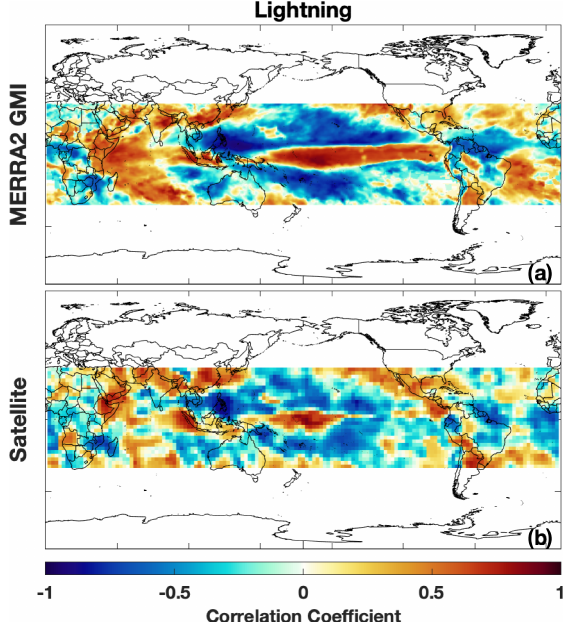
Figure 17. The regression of lightning NO emissions at 300hPa (a) and the lightning flash rate from the LIS/OTD time series (b) against the MEI. Lightning data are restricted to within 35 ◦ of the Equator because of the spatial coverage of the Tropical Rainfall Measuring Mission (TRMM) satellite on which LIS is